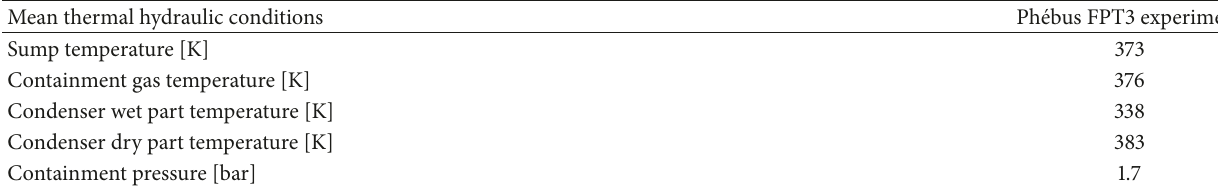
Table 6: Mean thermal hydraulic conditions of the chemistry phase